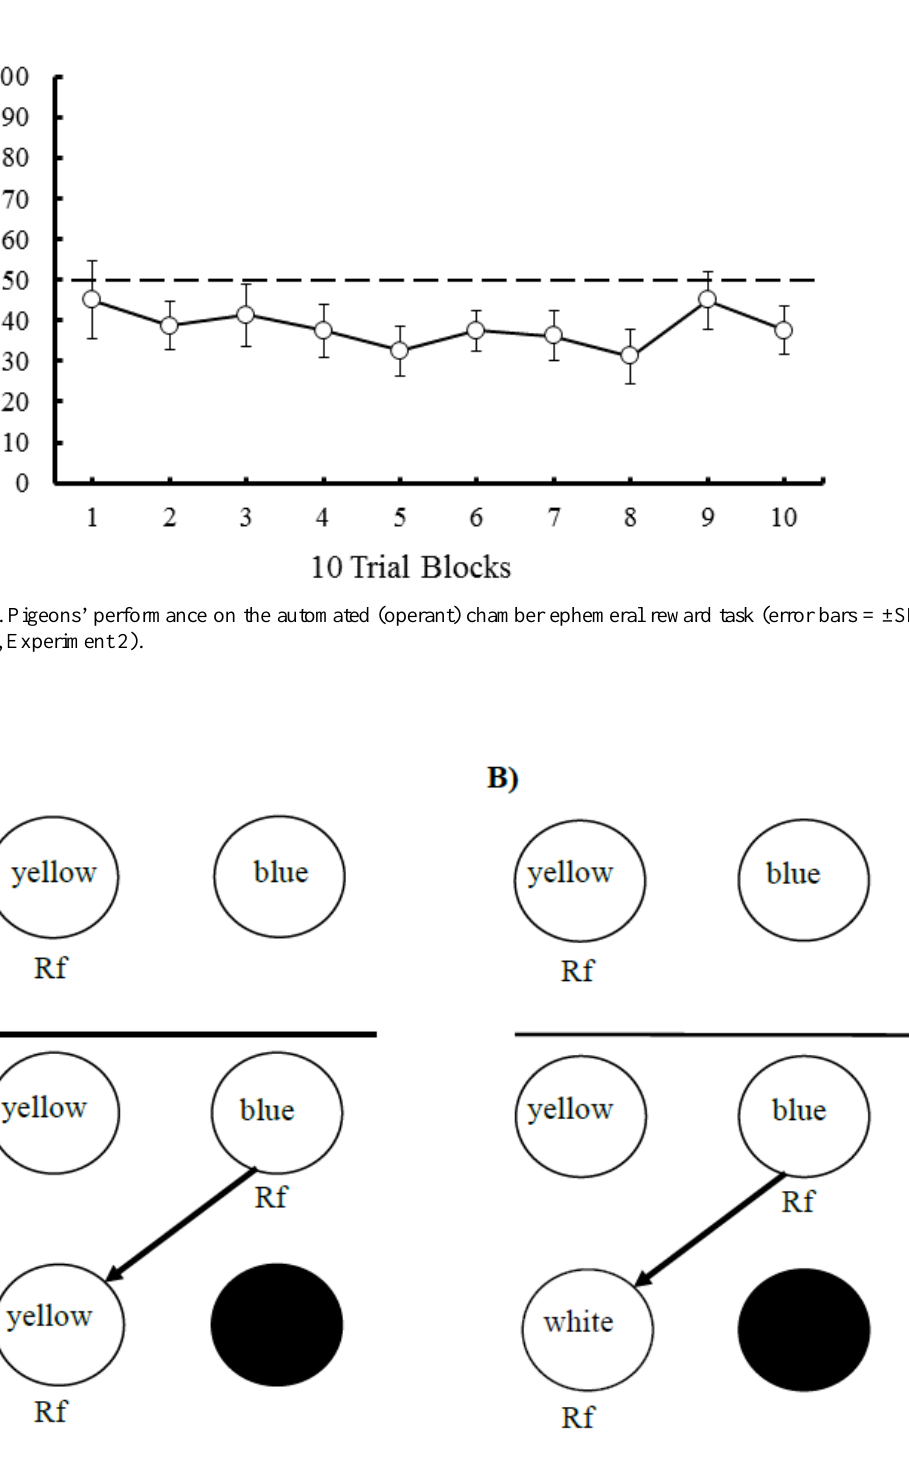
Figure 3 . Design of Zentall, Case, & Luang (2016), Experiment 3: (A) Procedure for control group in which there are twice as many reinforcements associated with the suboptimal choice color and all trials end with a response to the suboptimal choice color. (B) Procedure for the experimental group in which an equal number of reinforcements are associated with the optimal and suboptimal choice